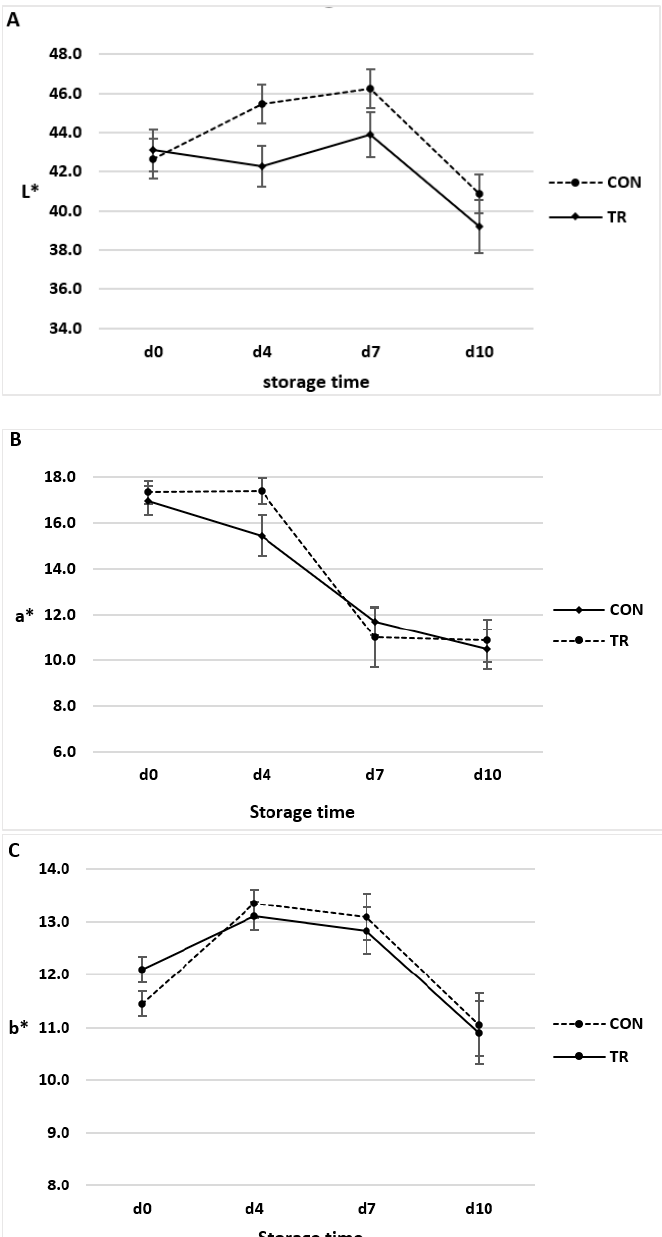
Figure 1. Colour indices of Longissimus lumborum of Charolais beef cattle fed control diet (CON) and diet supplemented with omega-3 lipid supplement (TR) in relation to storage time. n = 10; data are reported as mean ± SEM. ( A ) Lightness (L*) values: effects of treatment, p = 0.140; time, p < 0.001; time xtreatment, p = 0.109; ( B ) Redness (a*) values: effects of treatment, p = 0.648; time, p < 0.001; time x treatment, p = 0.570; ( C )Yellowness (b*) values: effects of treatment, p = 0.994; time, p < 0.001; time x treatment, p = 0.734.